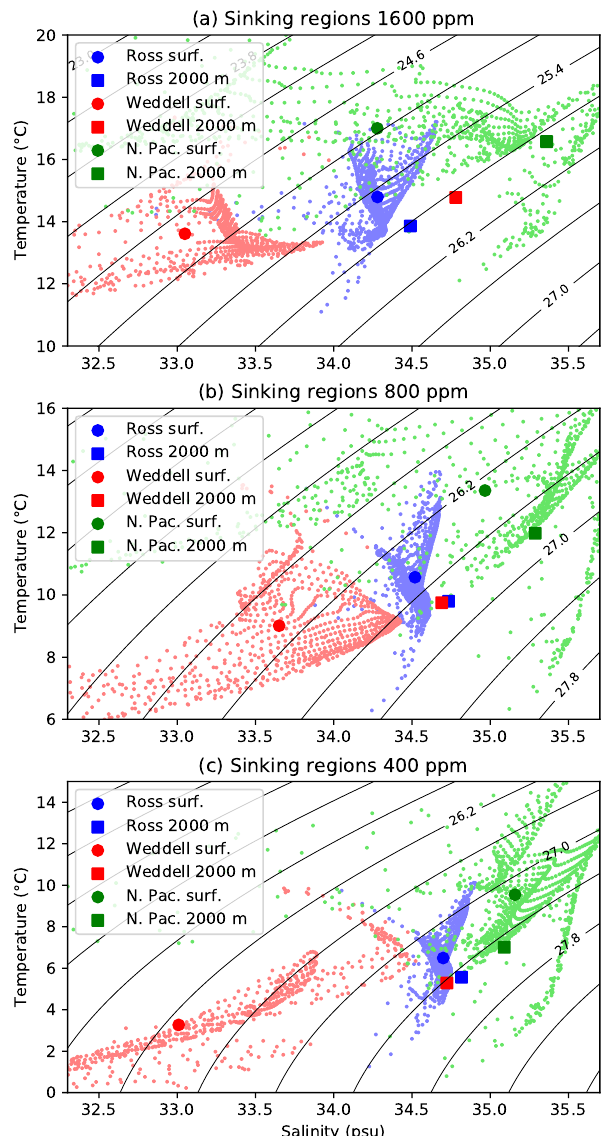
Figure 15. Temperature and salinity properties in the sinking regions, showing surface values during winter months: July to September in the Southern Hemisphere and January to March in the Northern Hemisphere. Values are taken south of 60 ◦ S in the Southern Hemisphere and north of 50 ◦ N in the North Pacific. Shelf values less than 200m depth are excluded. Bold circles indicate re- gional surface means, lighter dots indicate individual grid boxes and bold squares indicate regional annual means at 2000m. Contours of surface density are overlaid in each